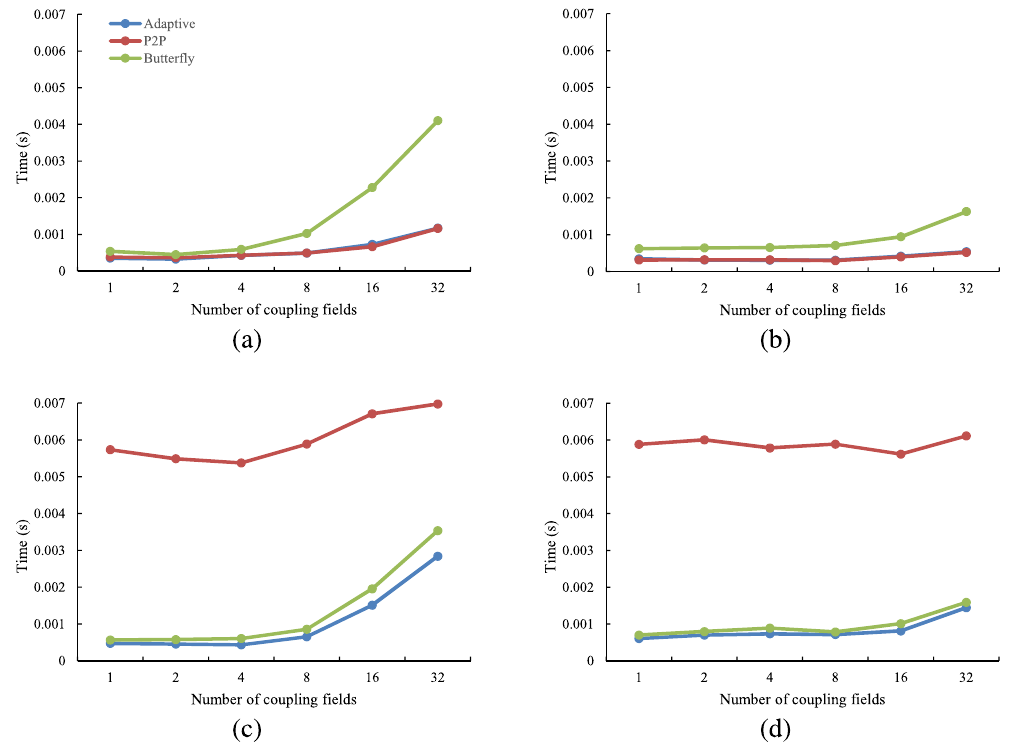
Figure 16. Average execution time ( y axis) of one data transfer between two toy models with the same rectangular grid (of 192 × 480 grid points) when varying the number of coupling fields transferred ( x axis). There are four simulation tests for the evaluation. In simulation (a) , each toy model is run with 256 processes, and the number of MPI messages per sender process in the P2P implementation is 12. In simu- lation (b) , each toy model is run with 1024 processes, and the number of MPI messages per sender process is in the P2P implementation 12. In simulation (c) , each toy model is run with 256 processes, and the number of MPI messages per sender process in the P2P implemen- tation is 48. In simulation (d) , each toy model is run with 1024 processes, and the number of MPI messages per sender process in the P2P implementation is